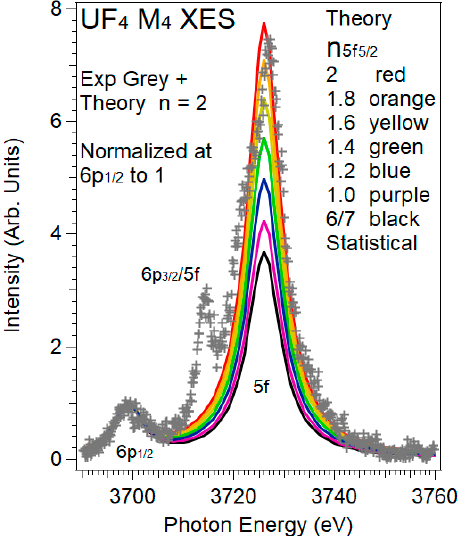
Figure 6. Shown here is the experimental M 4 XES spectrum of UF 4 and the simulated spectra for n = 2 and various values of n 5 / 2 . The simulation used normalized Lorentzian line shapes, with a half-width at half-max of Γ . For the 6p 1 / 2 , Γ = 3.5 eV. For the 5f peak, Γ = 4 eV. The 5f / 6p 3 / 2 peak is neglected in the